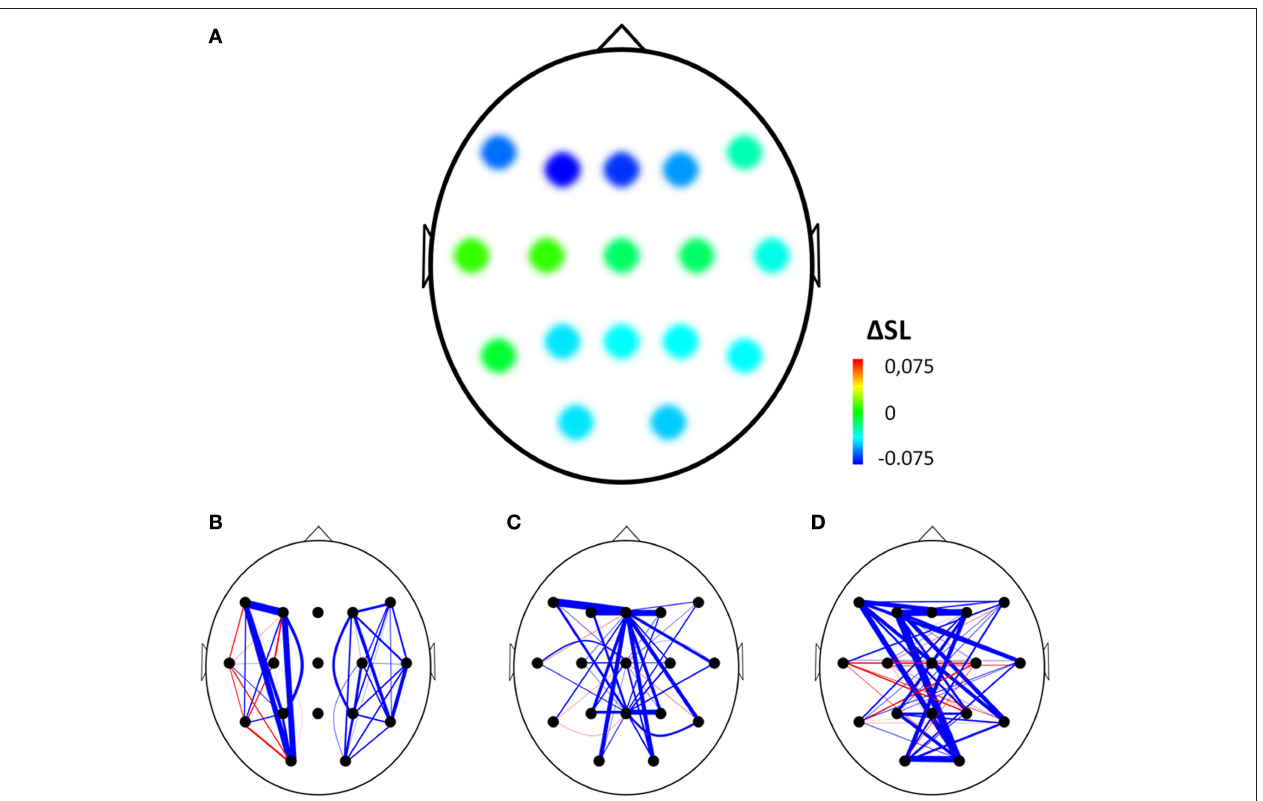
synchronization likelihood between two electrodes, red line indicates increase. Thickness of lines indicates extent of change after injection (thin = small, thick = large). Three types of edges are depicted: (b) within hemisphere edges, (C) edges between the central (midline) electrodes and the other electrodes, and (d) interhemispheric